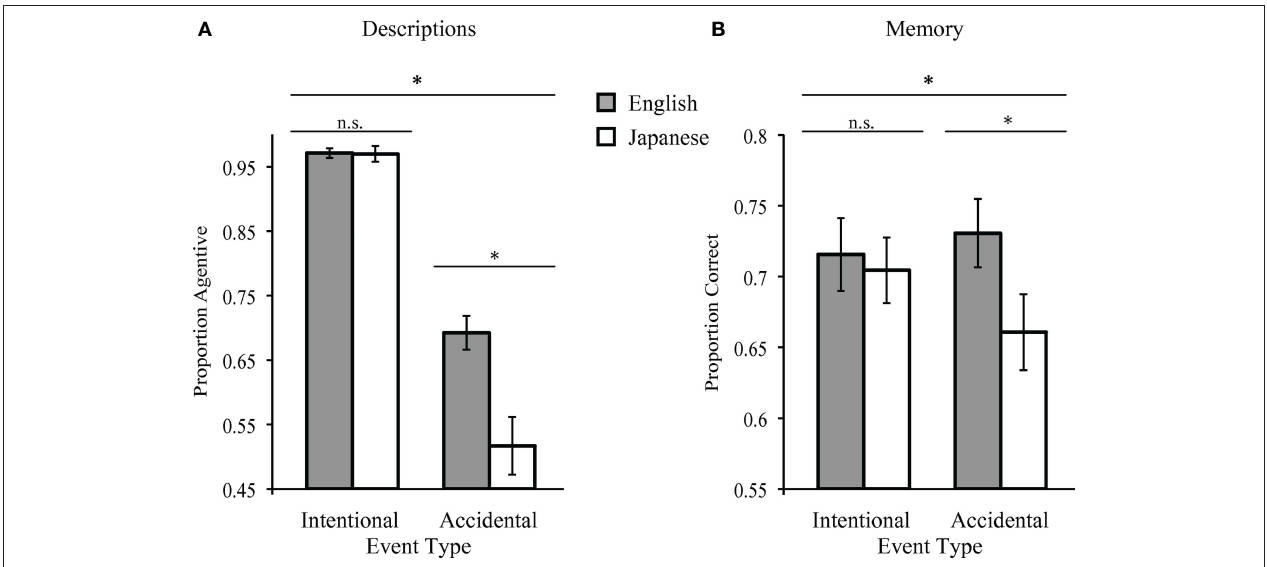
FIgure 2 | Describing and remembering agents in english and Japanese. (A) Causal event descriptions, with the mean proportion of agentive descriptions plotted on the y -axis, (B) causal agent memory, with mean proportion correct plotted on the y -axis. Error bars are ± 1